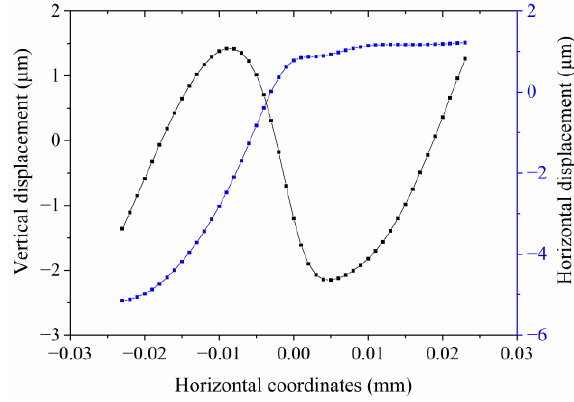
Figure 6. Amplitude characteristics of the chosen nodes.